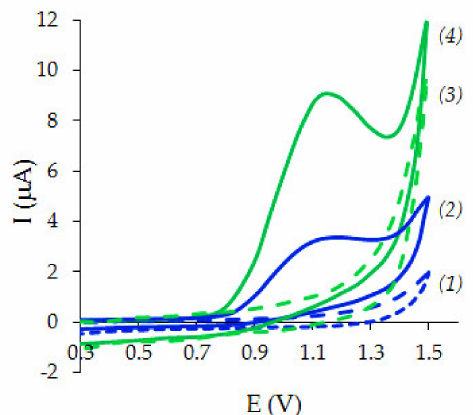
Figure 2. Cyclic voltammograms on the FCVE ( 1 , 2 ) and TrX100 / FCVE ( 3 , 4 ), in Britton–Robinson bu ff er (BRB) (pH 3) in the absence ( 1 , 3 ) and in the presence of 0.02 mM NO 2 − ( 2 , 4 ). Potential scan rate: 0.05 Vs − 1